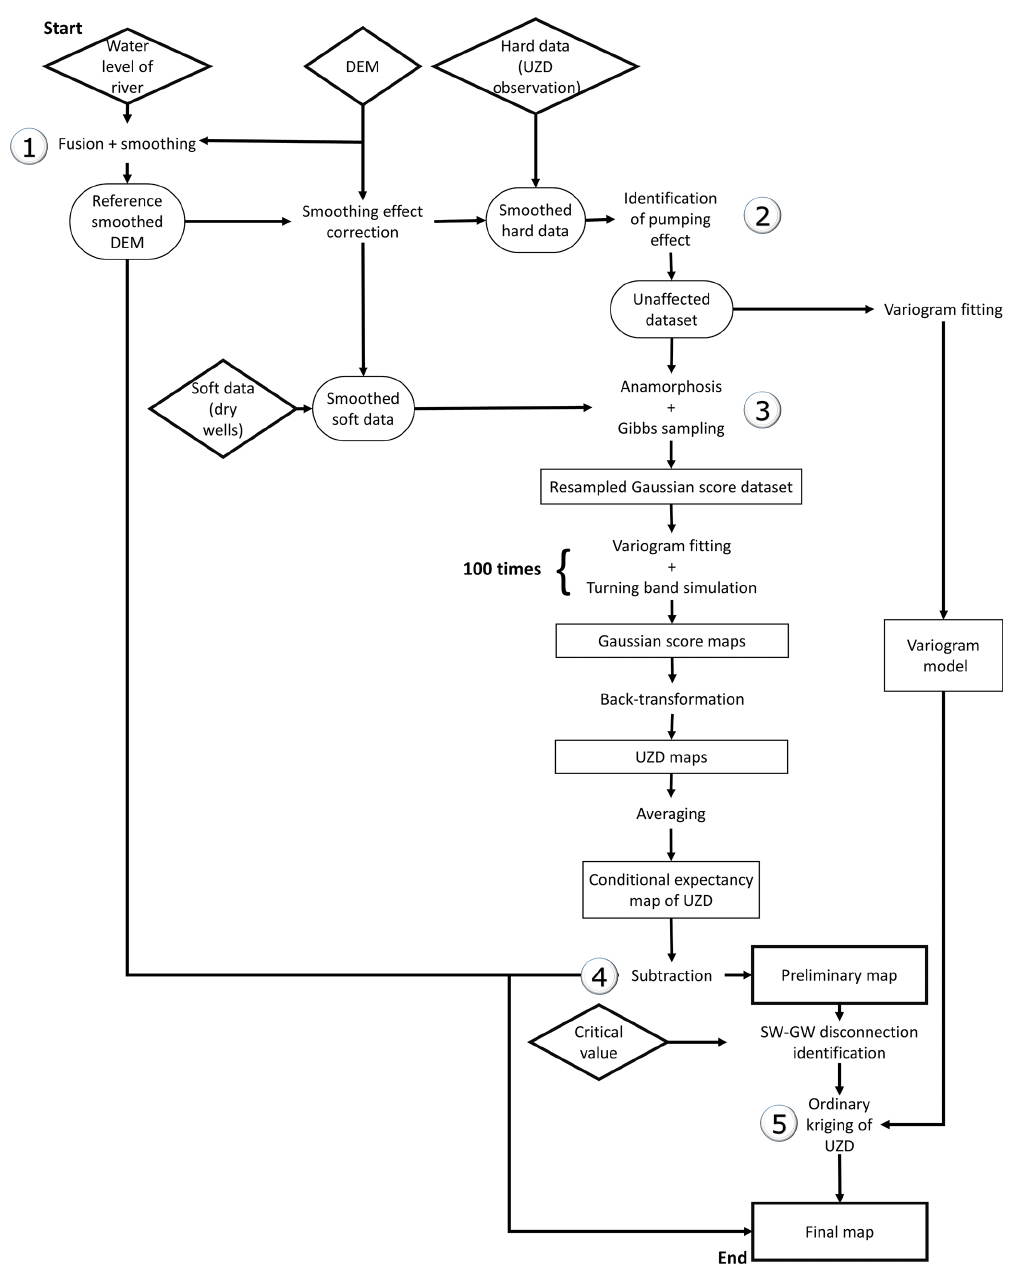
Figure 1. Flow chart for the mapping of the water table. Steps 1 to 4 for the first-guess map. Step 5 for the final map. UZD: unsaturated zone depth. Diamonds display raw data, ellipses display input data after pre-processing and squares display intermediary